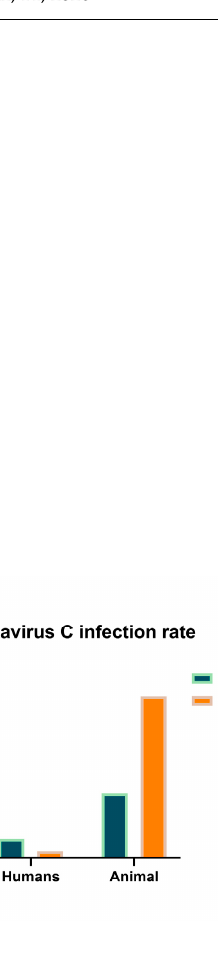
Figure 2. Bar chart of the RVC infection rates worldwide. ( A ) Bar chart of the RVC infection rates for 1980–2022, with the infected host as a partition unit and segmented nodes, as shown. ( B ) Bar chart of the infection rates of human infection with RVC at the intercontinental level. ( C ) Bar chart of the infection rates of RVC in animals (including swine, bovine, canine, and mink) across conti- nents.